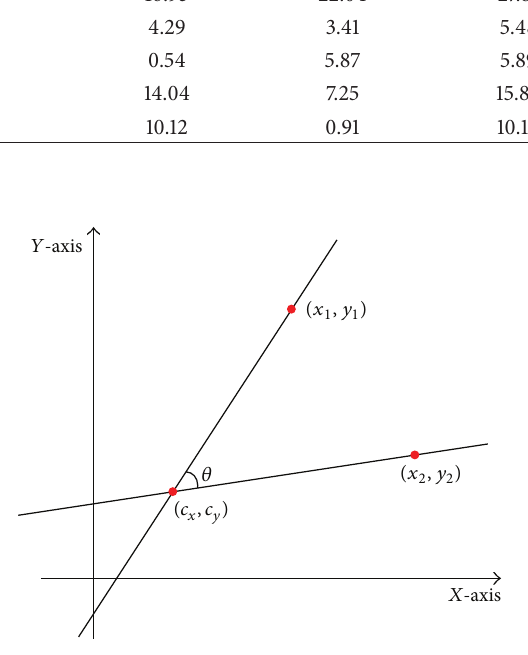
Figure 9: Example with three arbitrary points in a 2D